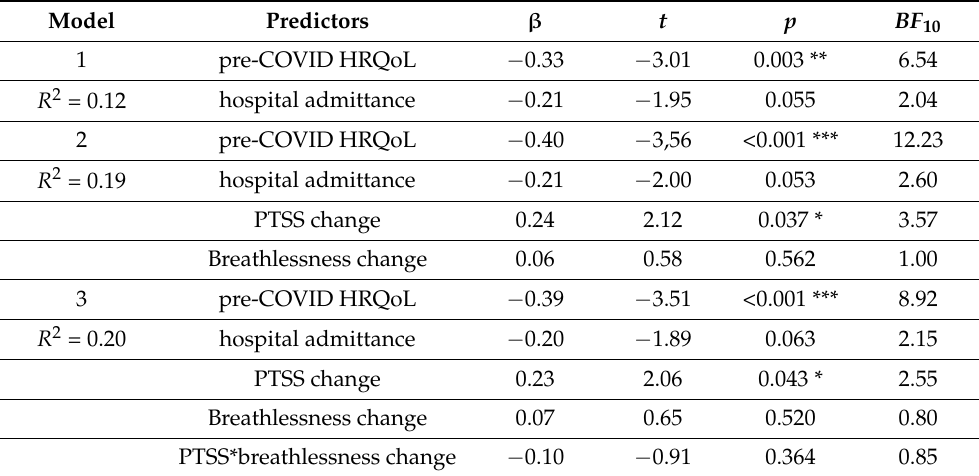
Table 3. Summary of hierarchical multiple regression analyses for predictors of fatigue improvement in PCS following